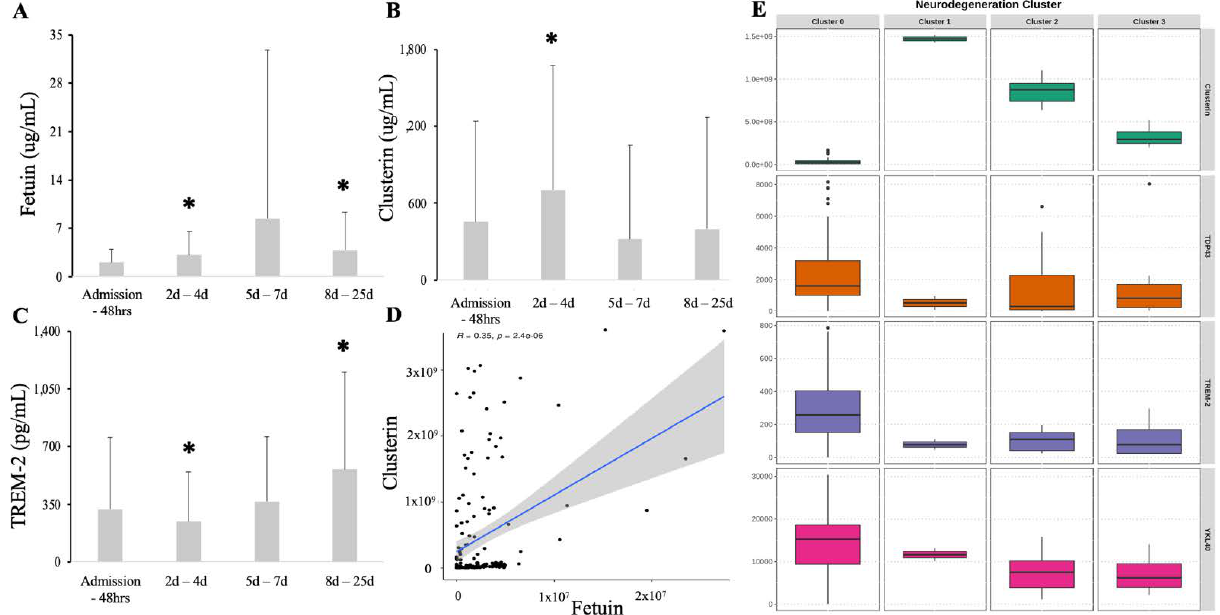
Figure 3. Serum levels of fetuin ( A ), clusterin ( B ), and TREM-2 ( C ) compared to admission. The correlation between fetuin and clusterin serum levels ( D ). Clusterin analysis revealed 4 clusters ( E ), one with depletion of clusterin (#0) while the clusters #1, #2, #3 are signified by depletion of TREM-2. * Statistical difference when compared to all patients at admission ( p < 0.05).